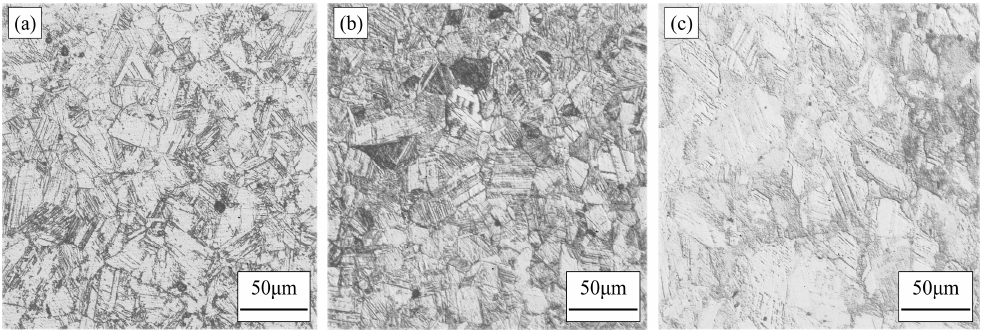
Figure 8. Optical microstructures of FeMnSiCrNi SMA undergoing compression ( T = 1000 ◦ C, ε = 0.9): ( a ) 0.5 s − 1 ; ( b ) 0.05 s − 1 ; ( c ) 0.005 s − 1